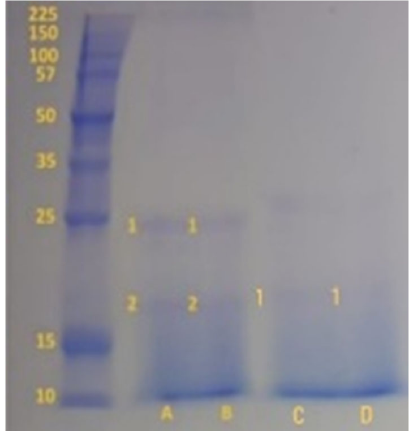
Figure 4. SDS ‐ PAGE result of partial and purified bacteriocin. Lanes A and B: partially purified bacteriocin with ammonium sulphate has two protein bands. Lanes C and D: purified bacteriocin with gel filtration chromatography has one protein bands. 1 refers to 26.69 kDa; 2 refers to 17.15 kDa.